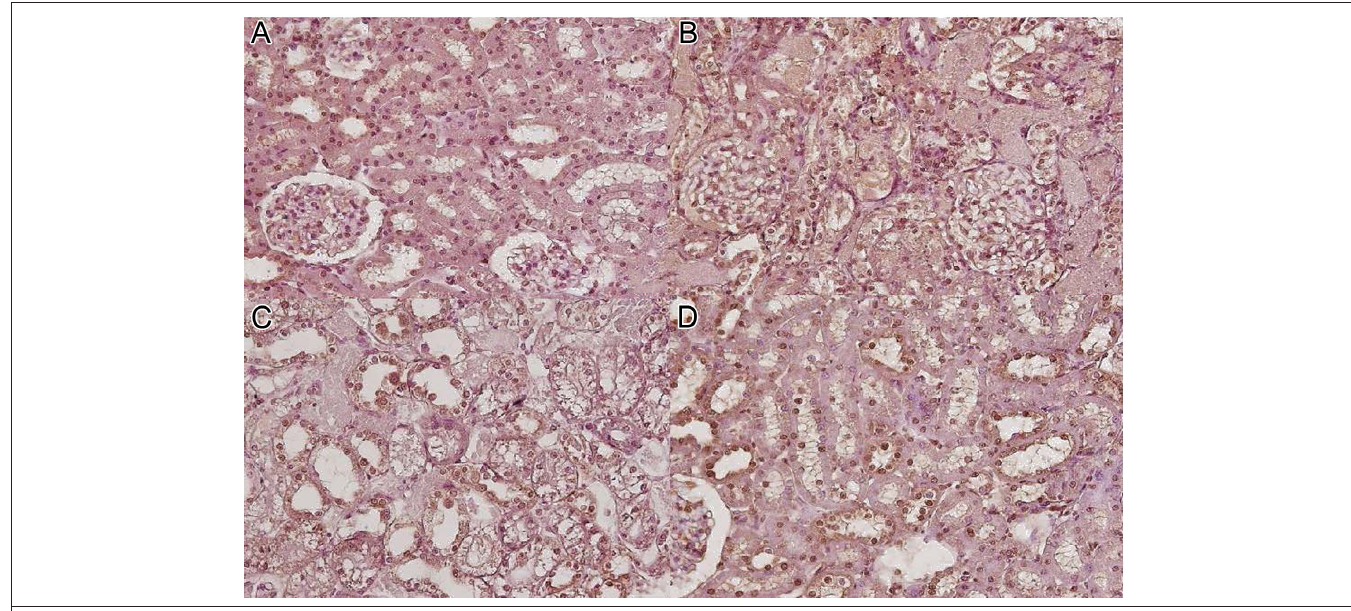
Figure 3. (a). SP group: Very few TUNEL-positive apoptotic cells, × 400. (b). AK group: TUNEL positive apoptotic cells, × 400. (c). AK+HPE group: TUNEL positive apoptotic cells with brown nuclei, × 400. (d). HPE group: TUNEL positive apoptotic cells, × 400. SP, serum physiologic; AK, amikacin; HPE, H. perforatum extract; TUNEL, triphosphate nick-end